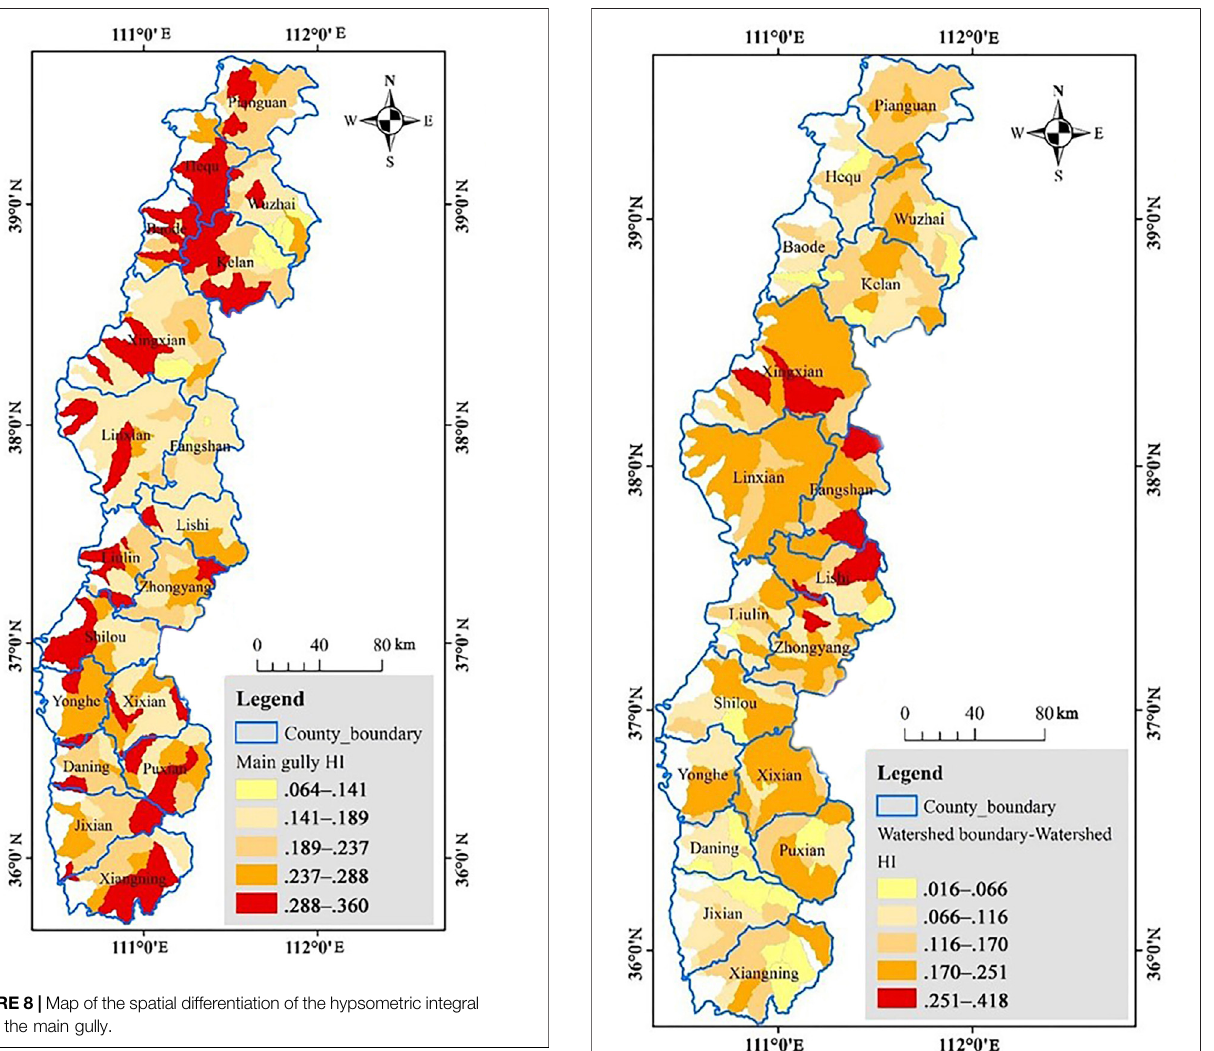
Frontiers in Earth Science |